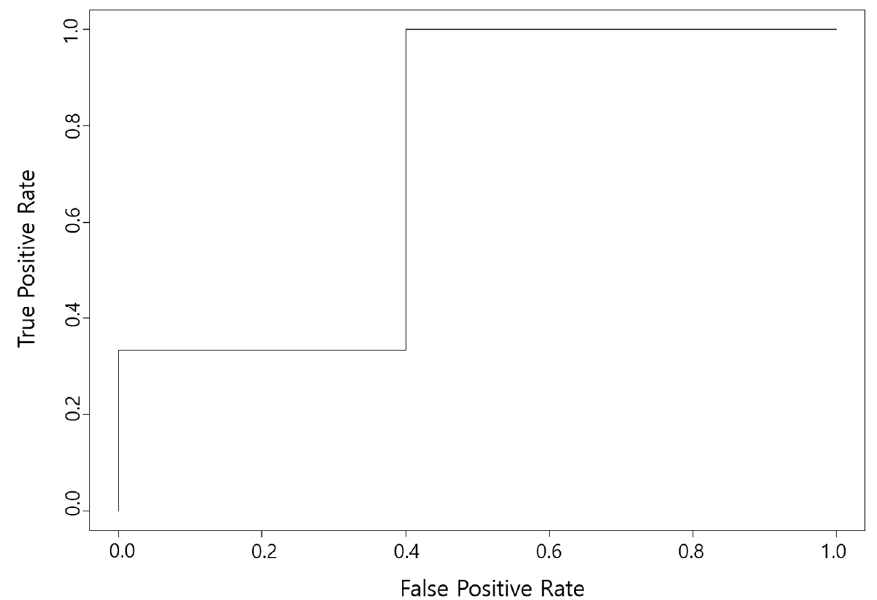
Figure 9. Evaluation results of pothole classification model in a complex environment using AUC.